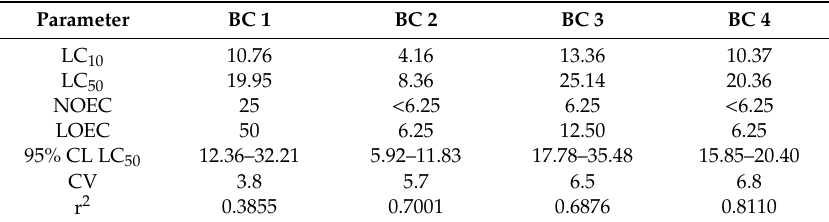
Table 7. Acute toxicity values of Lecane quadridentata to BCs 4 .